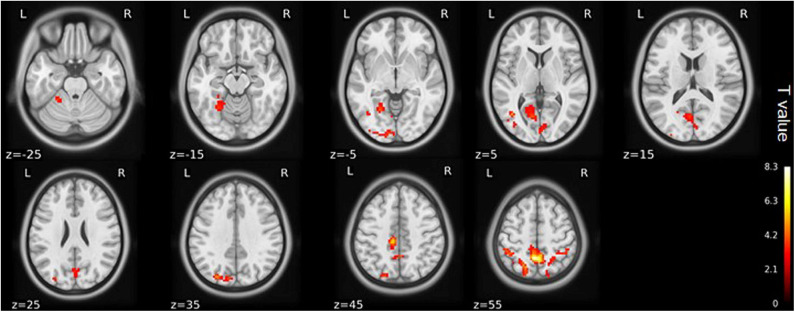
ALFF maps show differences between pre- and post-TKA patients, n = 15 (voxel-wise p < 0.01 and cluster-wise p < 0.025 for each tail, corrected by GRF). Paired-sample t-tests reveal ALFF increases in the left precuneus gyrus and middle temporal gyrus before TKA. The color bars range from zero to vmax which denotes the maximum t-value. ALFF, amplitude of low frequency fluctuation; TKA, total knee arthroplasty.